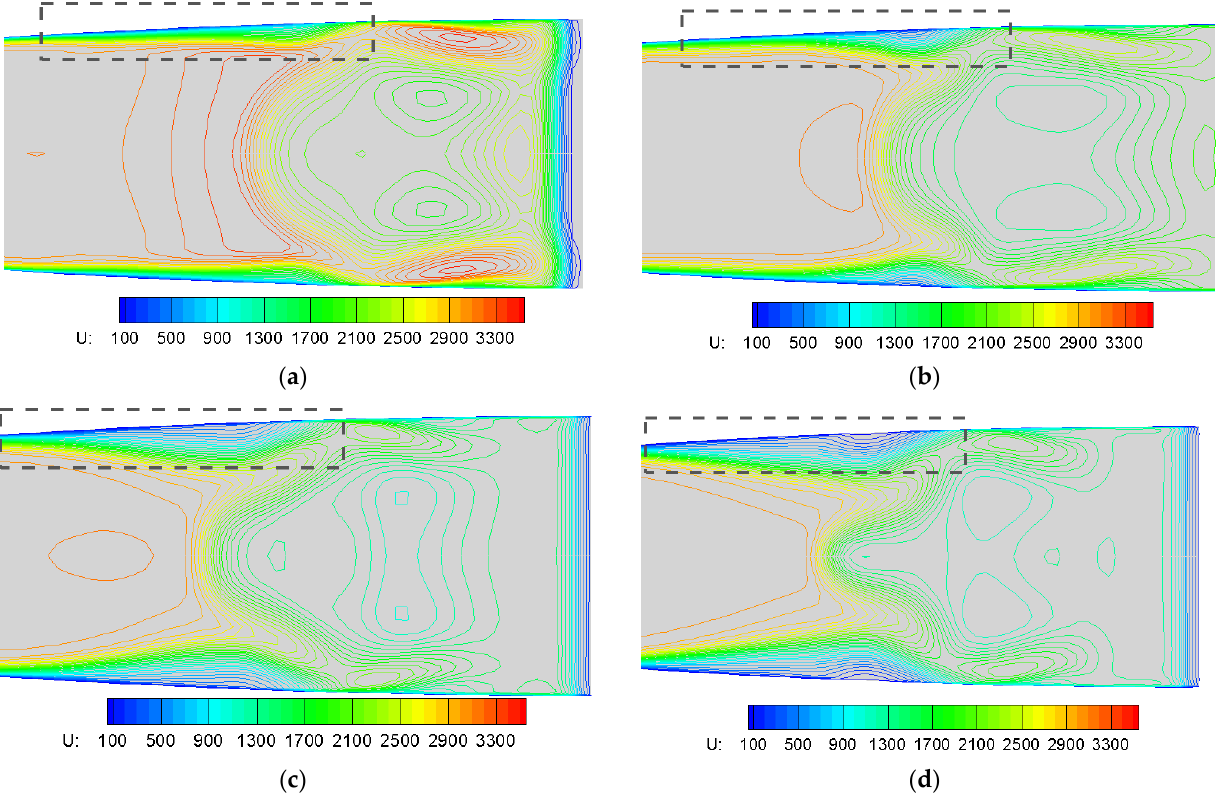
Figure 11. Schematic diagram of the low-velocity flow zone under different initial pressure values.